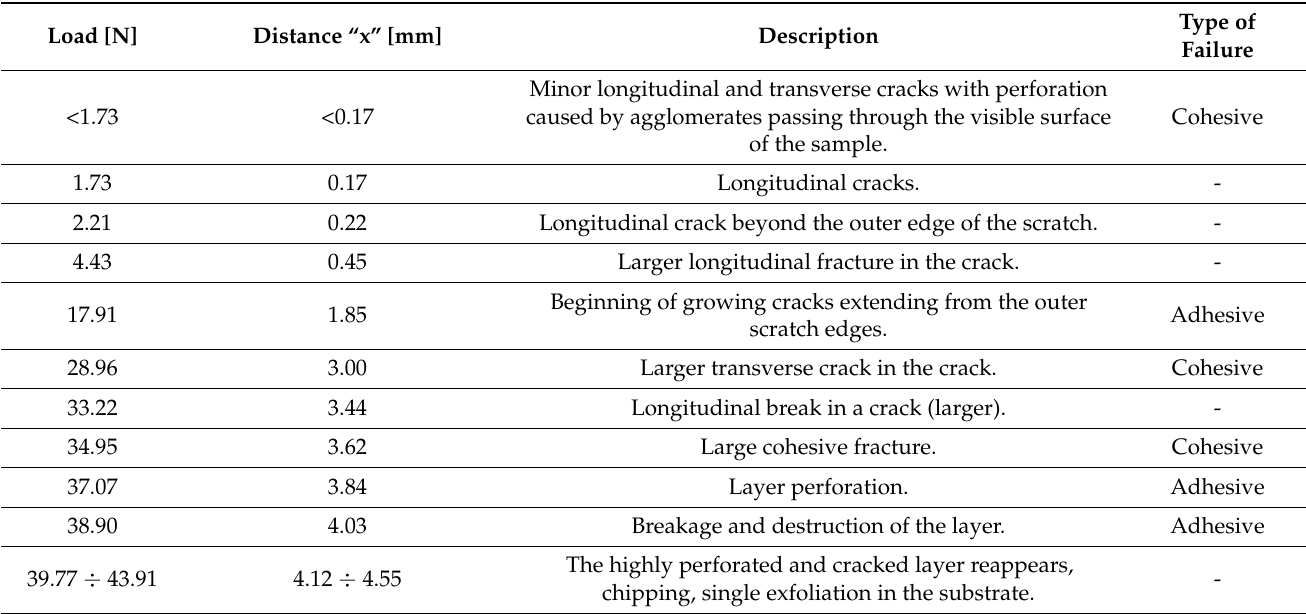
Table 8. Description of the scratch test for Ni-P/Si 3 N 4 (5 g/dm 3 ) layer.